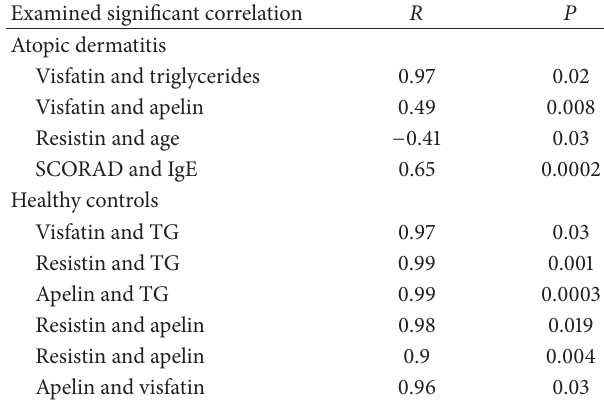
Table 4: Significant correlations between adipokine serum levels and other parameters in children with atopic dermatitis and healthy